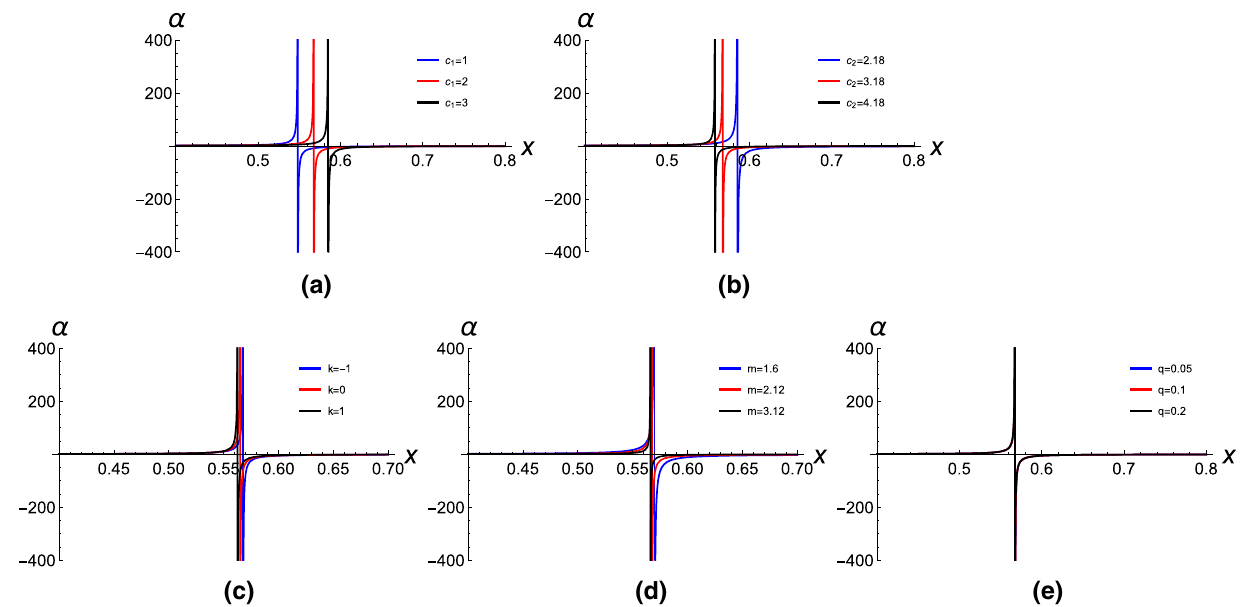
Fig. 5 α − x diagrams when the parameters change respectively and the initial parameters m = 2 . 12, c 1 = 2, c 2 = 3 . 18, q = 1 . 7, r c = 1, k = 1